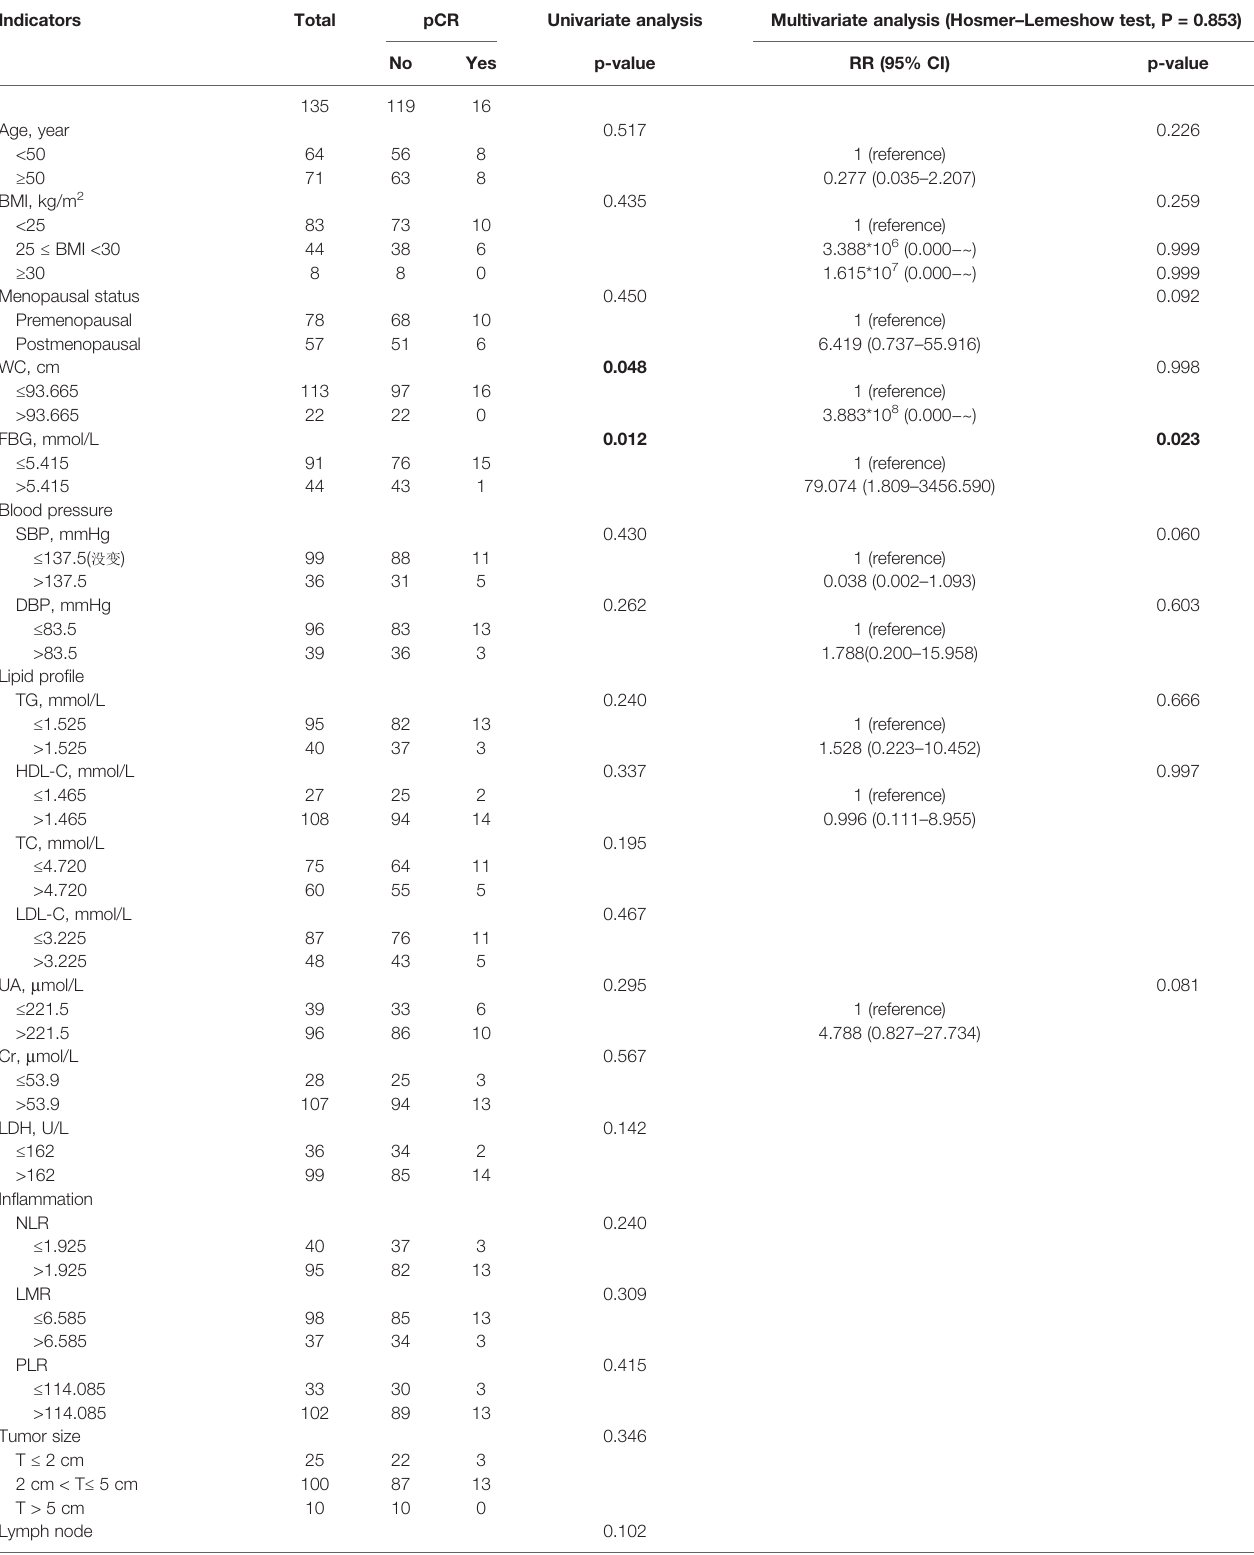
TABLE 3 | Univariate and multivariate analyses of laboratory and clinical indicators with BCNACT pathologic complete response on external validation patients.